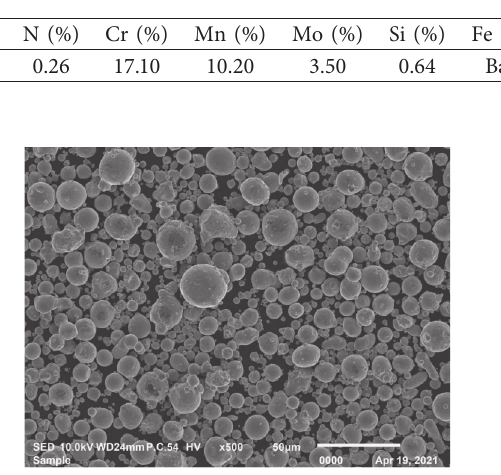
Figure 1: Micromorphology of raw steel